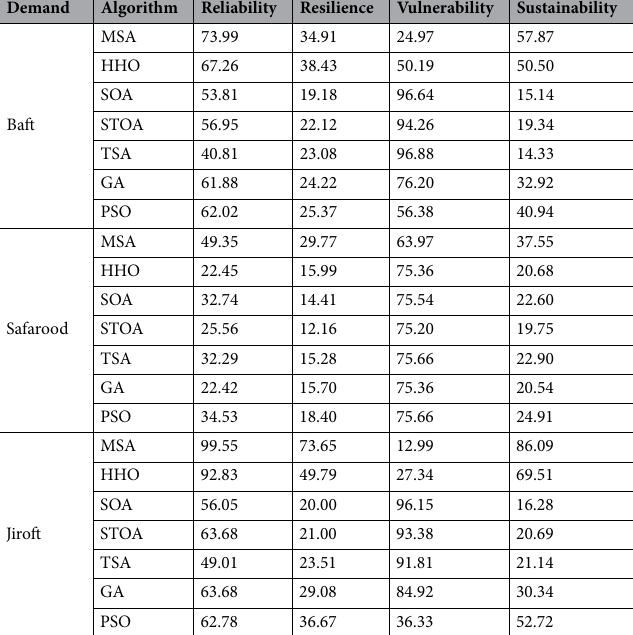
Table 3. Performance evaluation criteria of the reservoirs in the operation of the Halilrood multi-reservoir system.